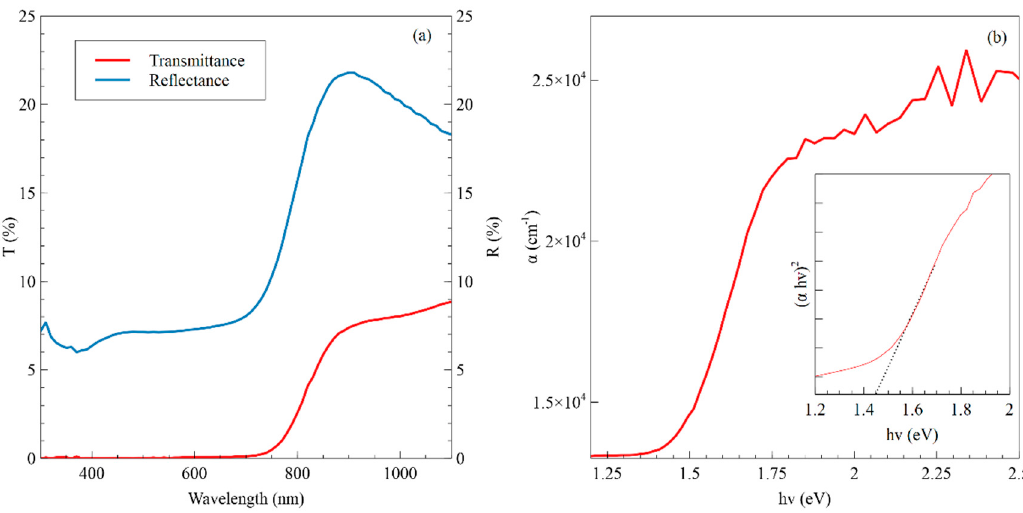
Figure 4. ( a ) Transmittance and reflectance measurements for a typical CZTS thin film using the binary nanoink. ( b ) Absorption coe ffi cient calculated for CZTS film, derived from transmittance and reflectance. The inset displays a Tauc plot based on absorption coe ffi cient, with linear portion of plot fit extrapolated for the optical bandgap at 1.44